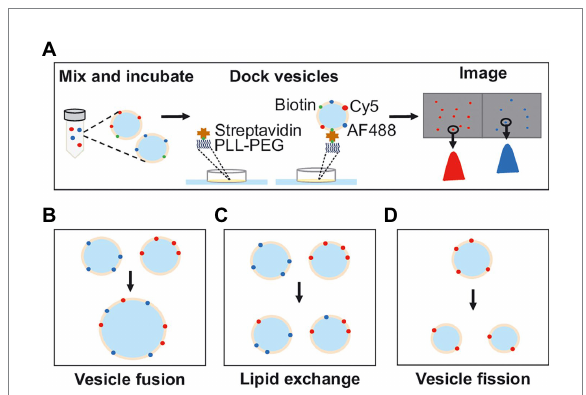
FIGURE 1 (A) Schematic illustration of the experimental procedure. Vesicles from two differently labeled populations are incubated together. After incubation, the vesicles are docked onto a passivated glass surface and imaged in two wavelength channels. The images are analyzed by detecting the positions, number of vesicles, and vesicle intensity. (B) Fusion between two differently labeled vesicles results in a reduced number of vesicles and colocalization of vesicles in the two wavelength channels with intensities similar to before vesicle mixing. (C) Lipid exchange results in an unchanged number of vesicles and colocalization between the vesicles in the two wavelength channels but with varying intensities compared to before vesicle mixing. (D) Fission, where only one vesicle population is needed, results in an increase in the number of vesicles and a decrease in the vesicle